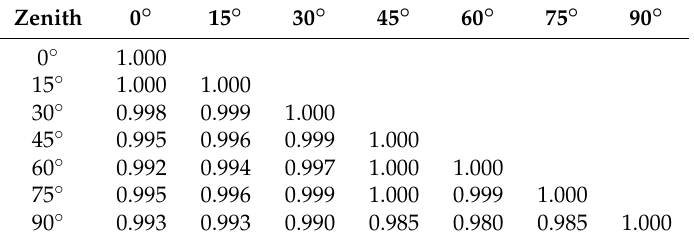
Table 2. The correlation between azimuthal-average spectral radiances and different zenith angles.